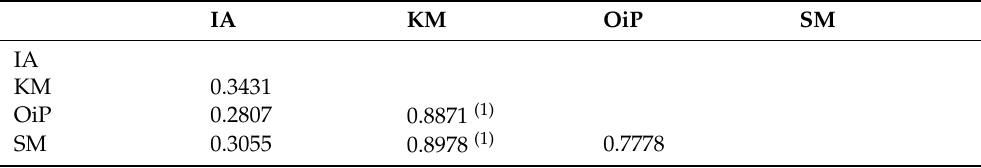
Table 8. Assessment of discriminant validity of the path model in phase three using the HTMT2 criterion. IA